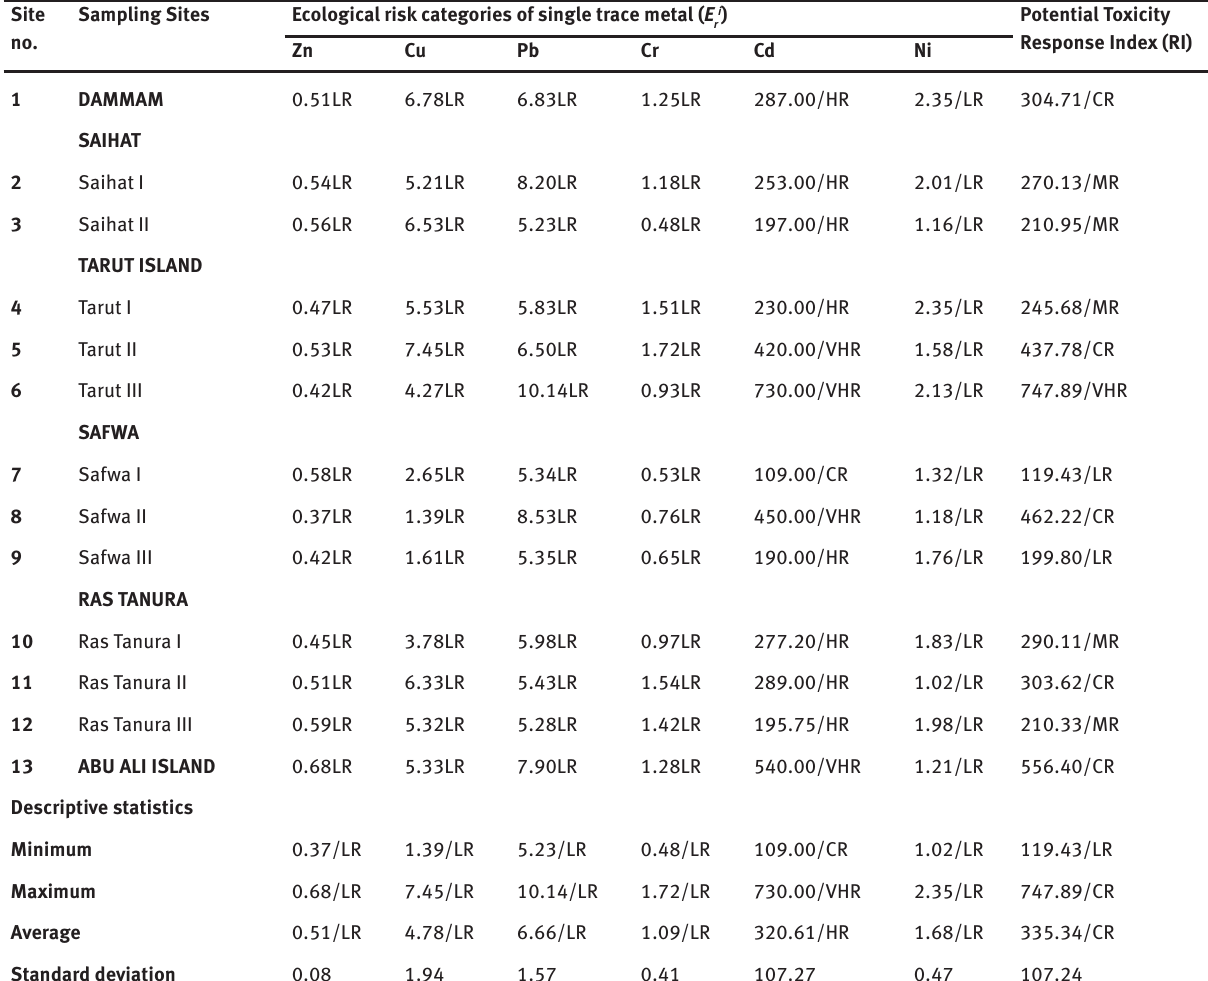
Table 7: Potential ecological risk indices ( E ri ) and potential toxicity response index (RI) of trace elements. Site Sampling no.